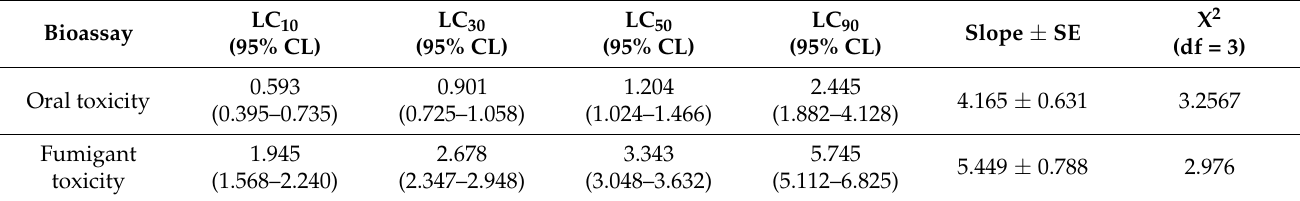
Table 2. Probit analysis of the oral and fumigant toxicity of Artemisia annua floral essential oil on 4th instar larva of Glyphodes pyloalis .